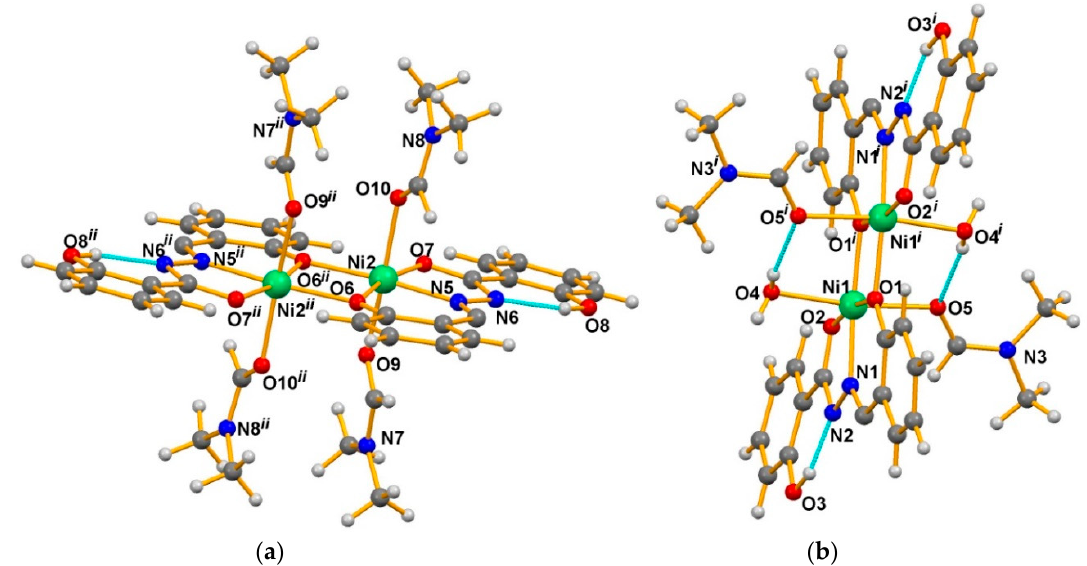
Figure 1. Molecular structure of compound 1A with atom numbering scheme. ( a ) nickel(II) coordinated with two DMF, ( b ) nickel(II) coordinated with one DMF and one water molecule. Sky-blue doted lines